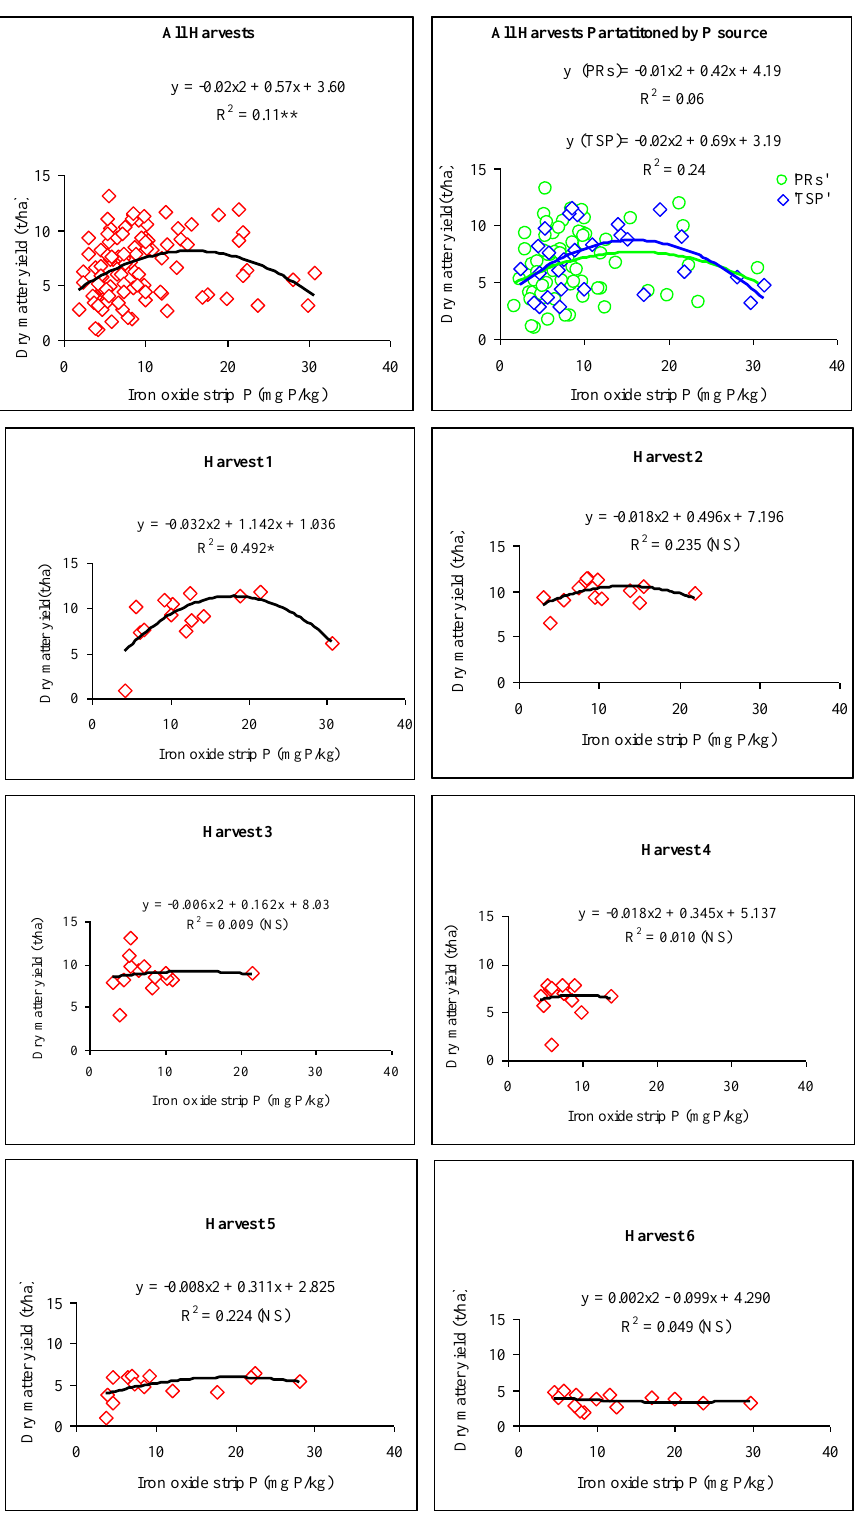
FIGURE 3C. Relationship between strip extractable P and Setaria DMY for all harvests, all harvests partitioned into different P sources, and harvests 1–6. NB: * and ** denote significance at 5 and 1%, respectively. NS denotes not